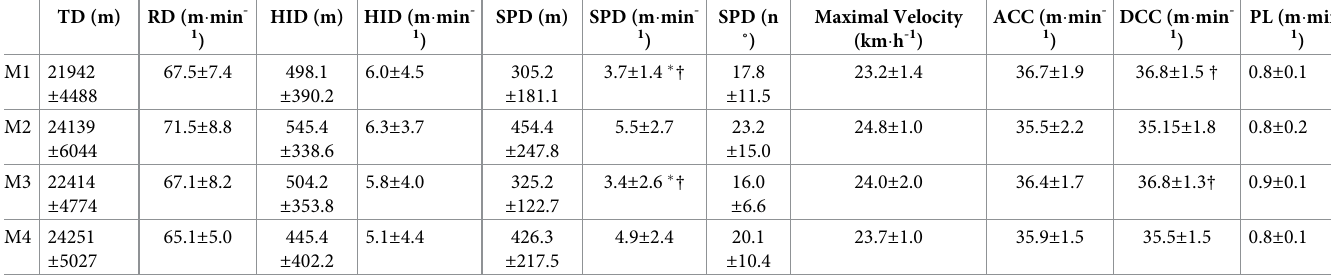
Table 1. Mean external load of four consecutive